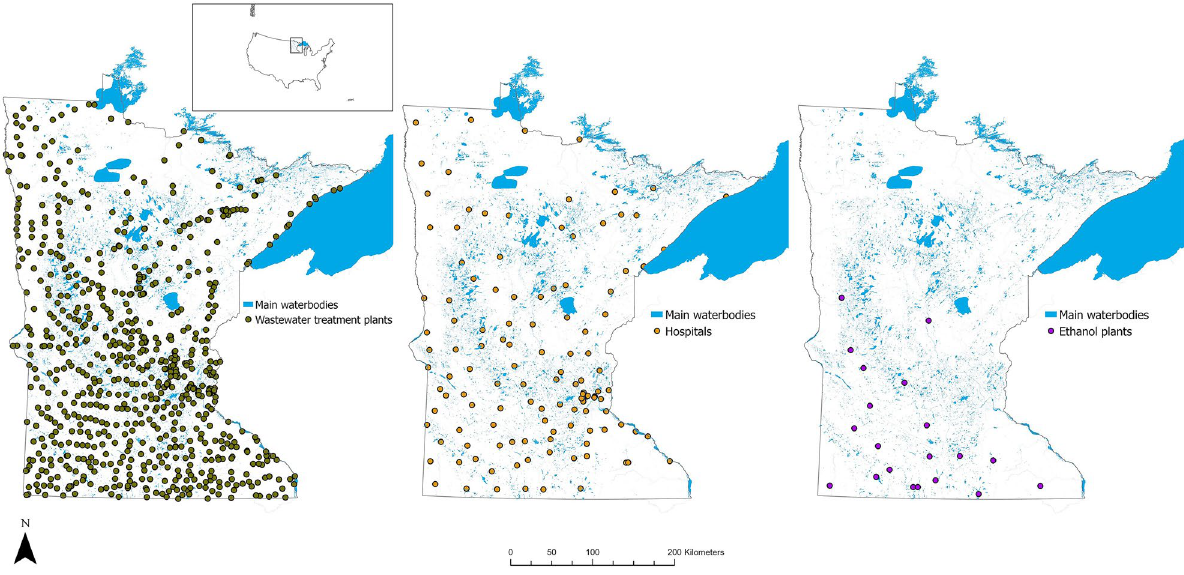
Figure 1. Point map of locations for wastewater treatment plants, hospitals, and ethanol plants in